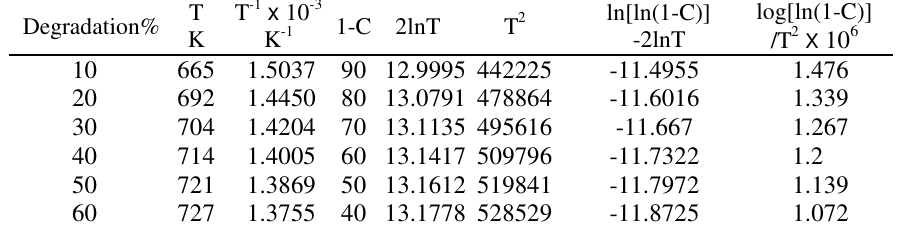
Table 4. Calculation of activation energy for the degradation of nylon-66